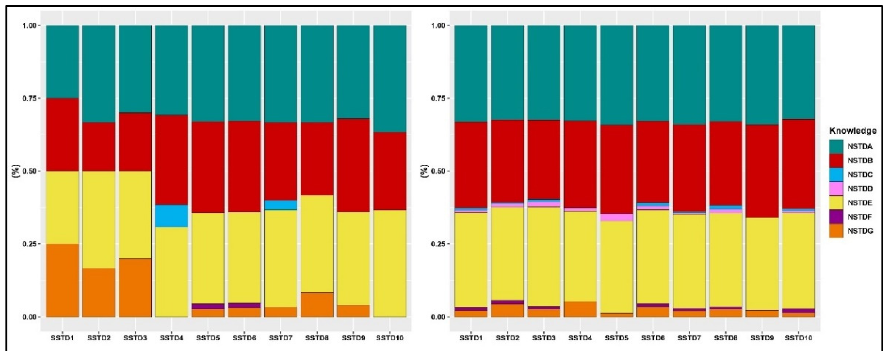
Figure 3. Prevalence of self-reported STI knowledge among men ( left ) and women ( right ) who ex-